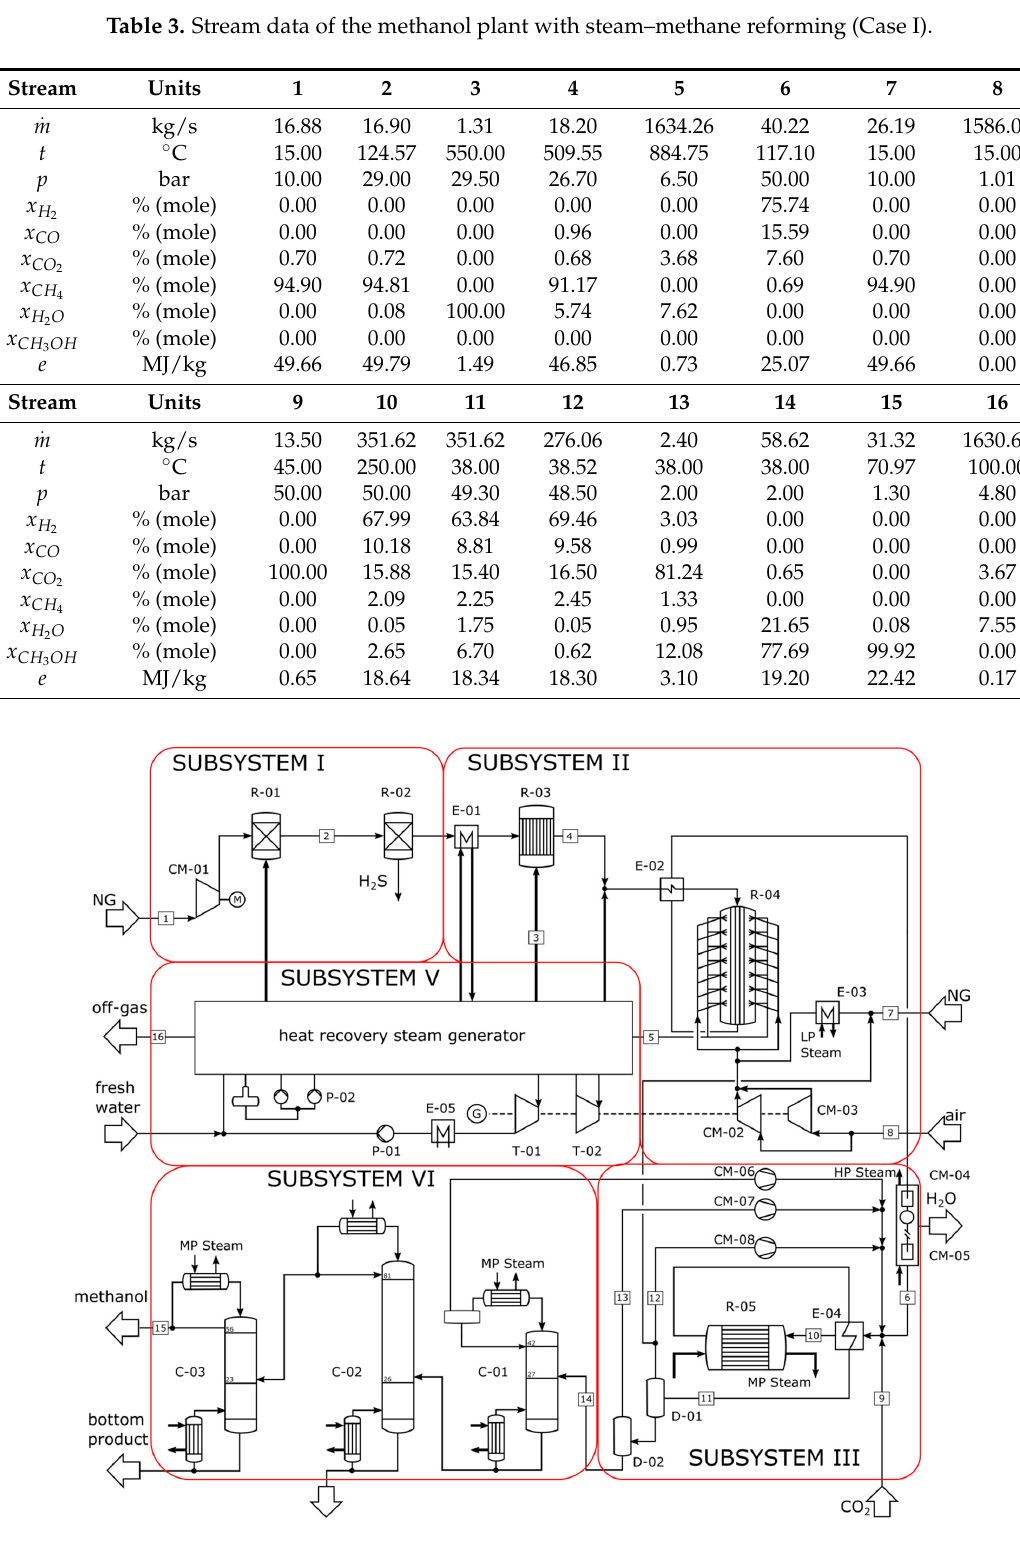
Figure 3. Process flow sheet of the methanol plant with steam–methane reforming (Case I).